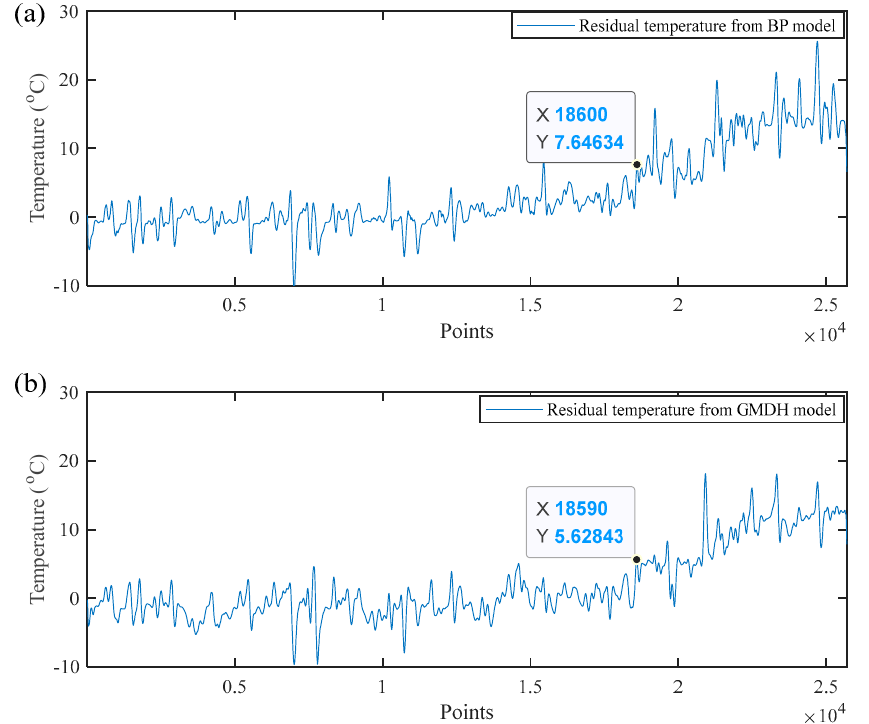
Figure 11. Residual temperature of the gearbox oil. ( a ) Residual temperature from a BP model, ( b ) Residual temperature from a GMDH model.